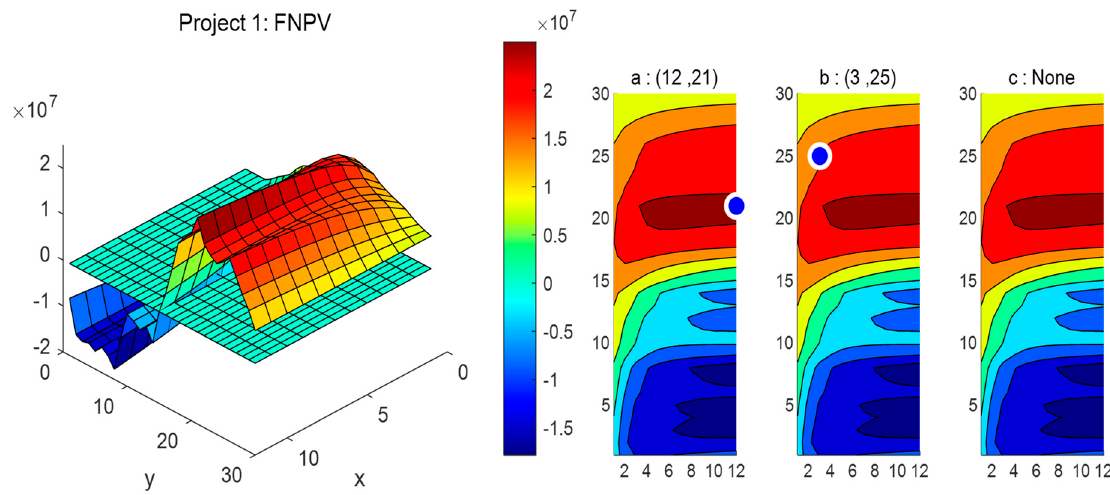
Figure 15. Decision − making for project 1.